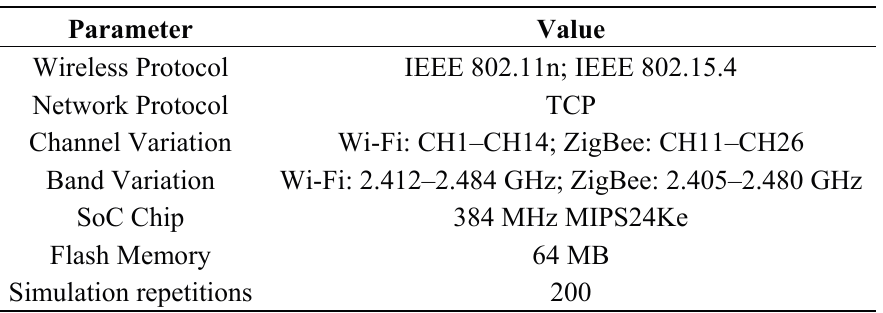
Table 1. Simulation Parameters.